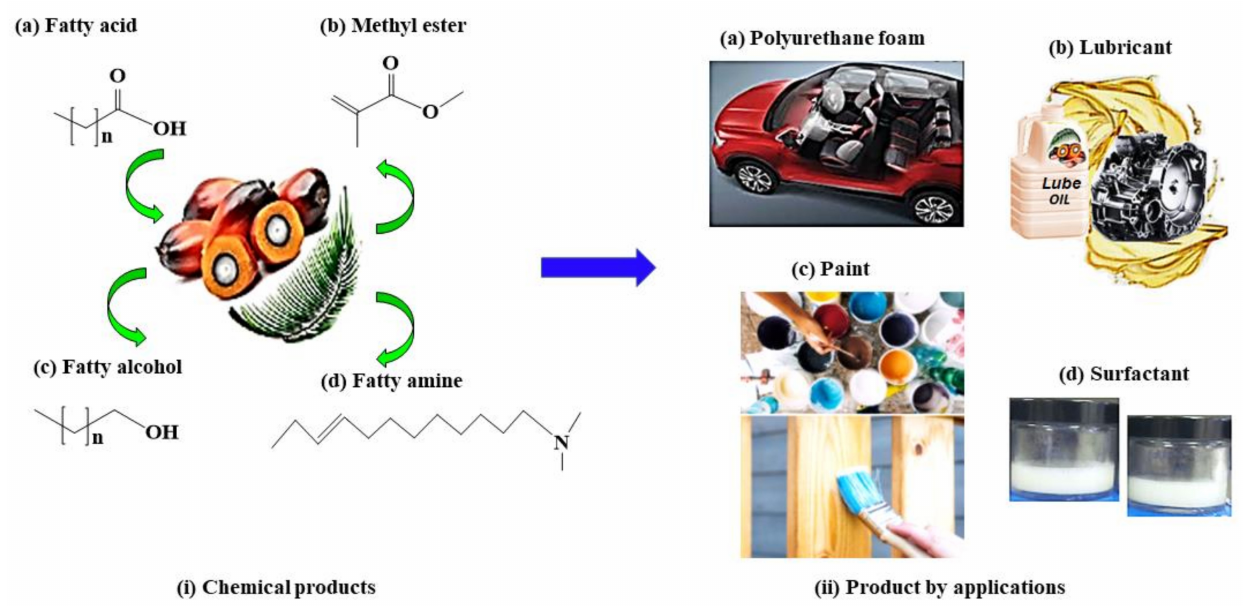
Figure 1. Palm oil used in oleochemical industry: ( i ) chemical products ( ii ) and formulated products by